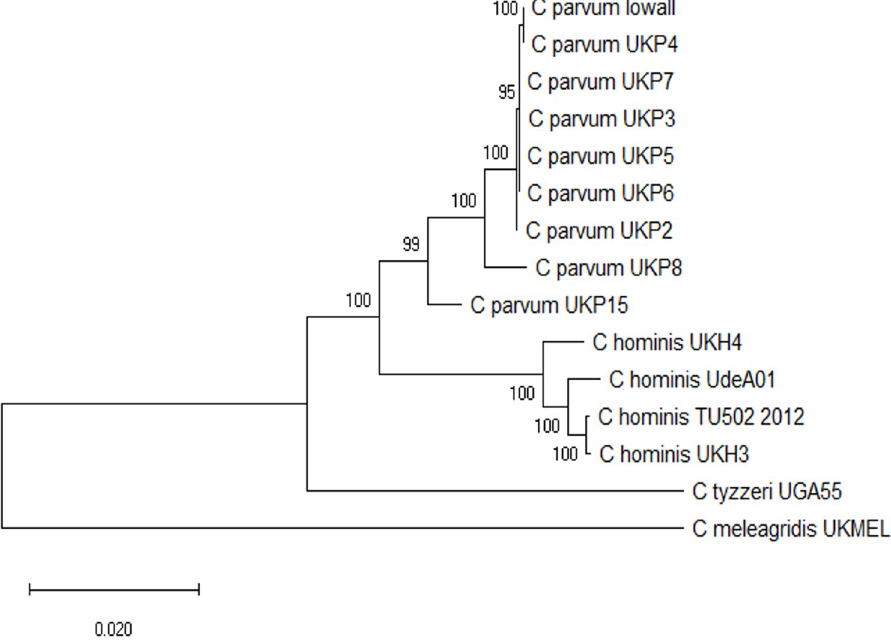
Fig 1. Phylogenetic analysis with the CS of the seven markers in the Cryptosporidium genomes used for the validation strategy.